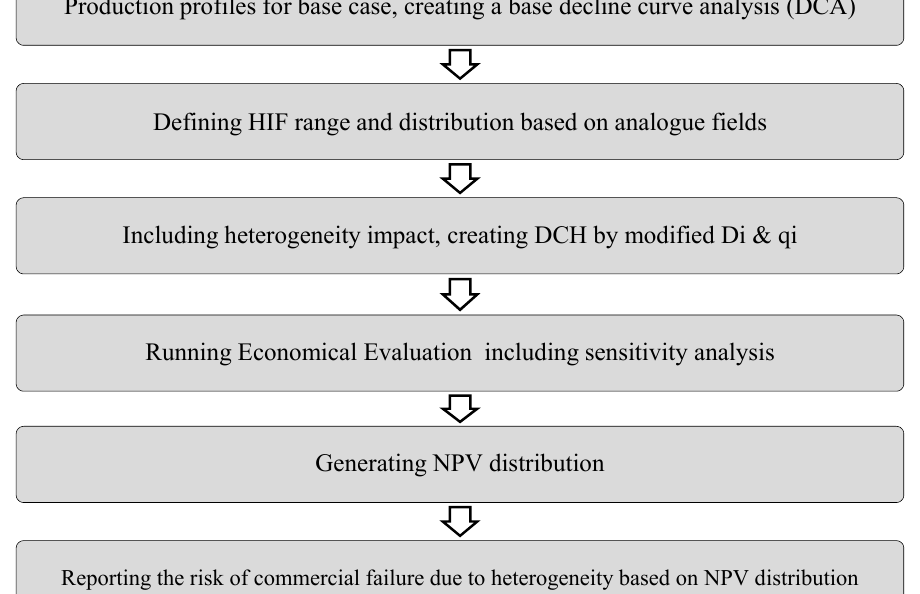
Figure 4. Workflow of Risk of Commercial Failure (RCF) calculation.